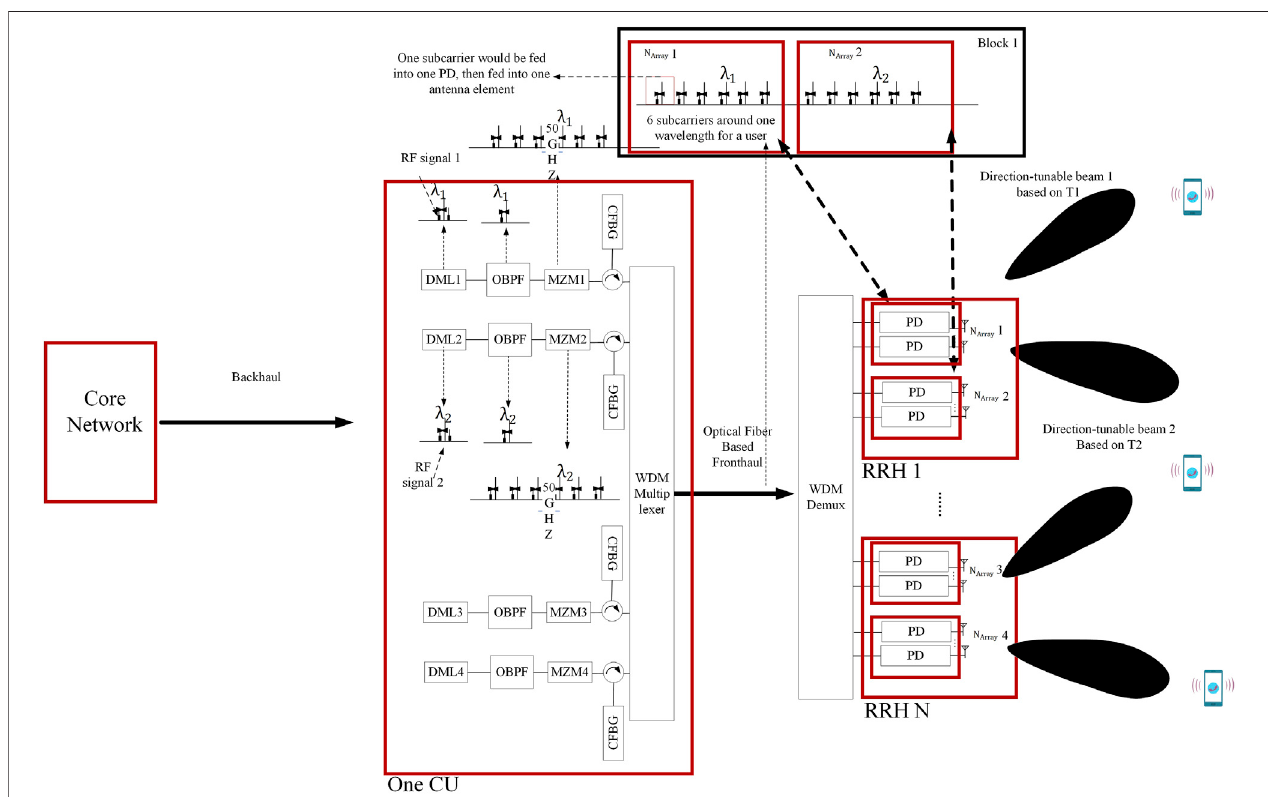
FIGURE 2 | Proposed A-RoF system model. (DML: Directly Modulated Laser, OBPF: Optical Bandpass Filter, MZM: Mach-zenhder Modulator, CFBG: Chirped Fiber Bragg Grating, WDM: Wavelength Division Multiplexing, RF: Radio Frequency, CU: Central Unit, RRH: Remote Radio Head, PD: Photo-detector).